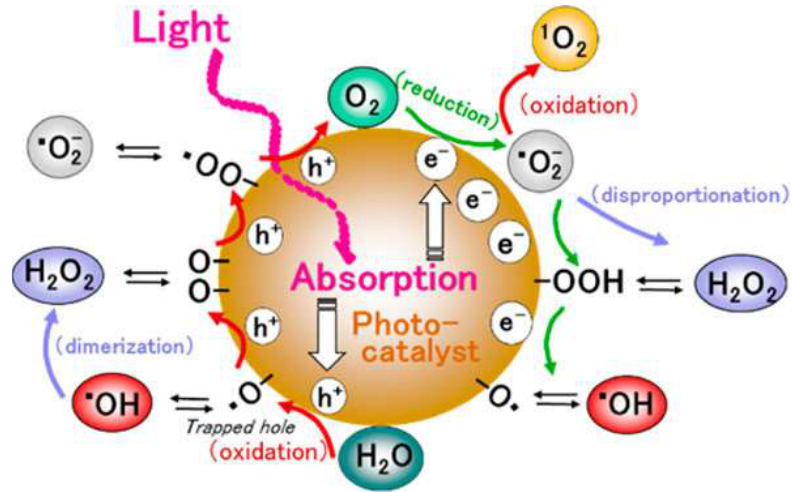
Figure 16. Reactive oxygen species generated in the photocatalytic oxidation steps of water. Reproduced from [146], Copyright 2017, American Chemical Society.